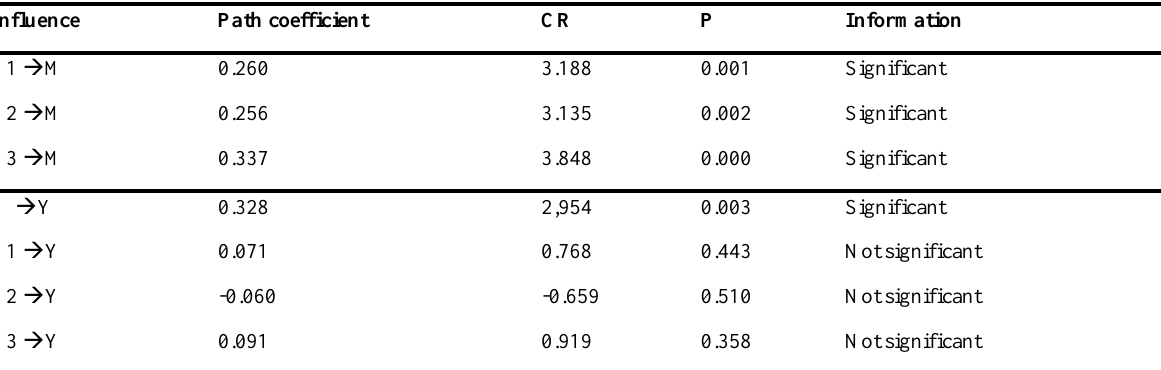
Table 3: Table of results of direct effect with